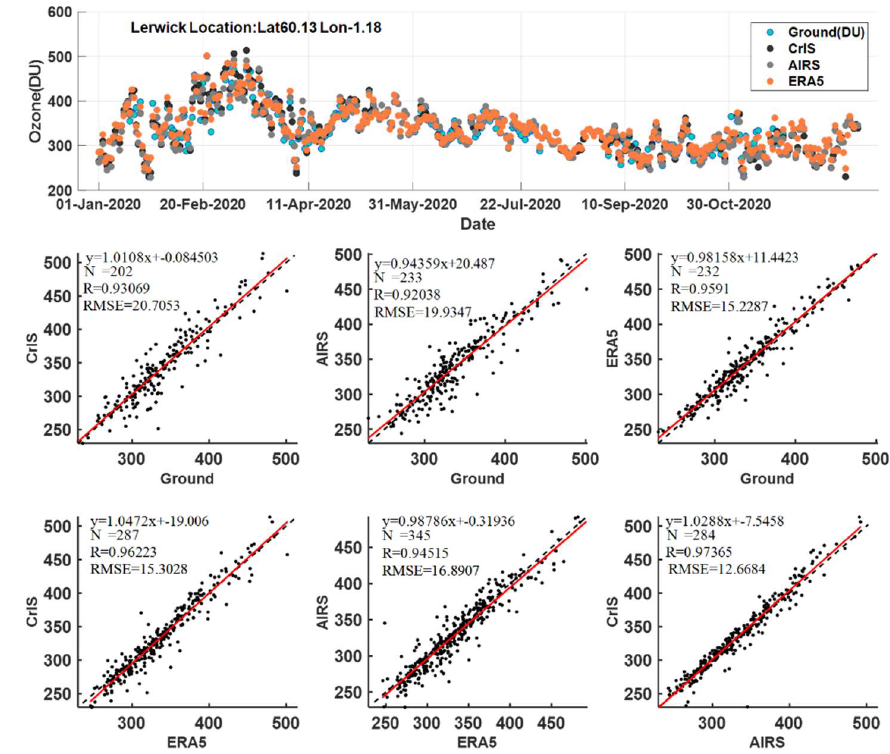
Figure 5. Same as Figure 4 but for Lerwick site.